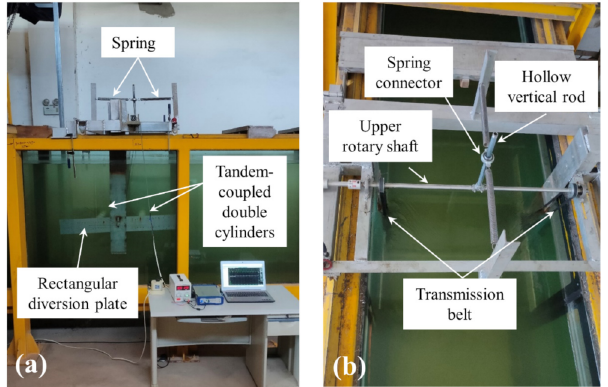
Figure 6. Physical models of FIR system: ( a ) Front view; ( b ) Vertical